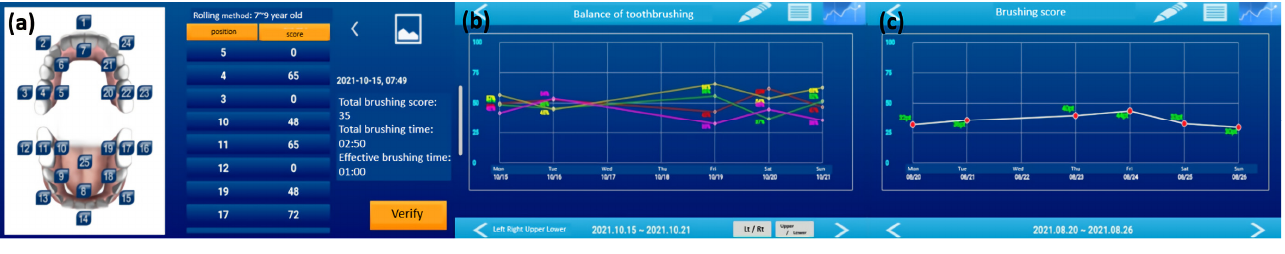
Figure 3. The application of the smart toothbrush. ( a ) The score expresses the brushed area and how well the child brushed. ( b ) The graph shows the upper, lower, left, and right balance of toothbrushing. ( c ) The graph shows the score after brushing teeth every day.